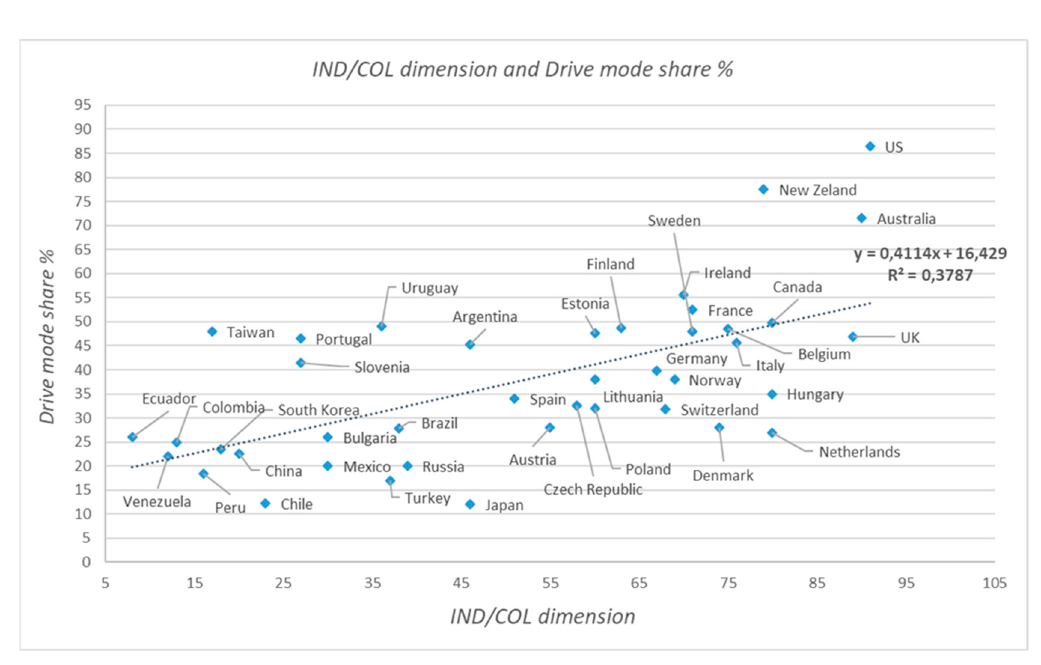
Table 7. Results of linear function model Equation (5). R (cid:2870) = 0.554 , sample size N = 35. Coef